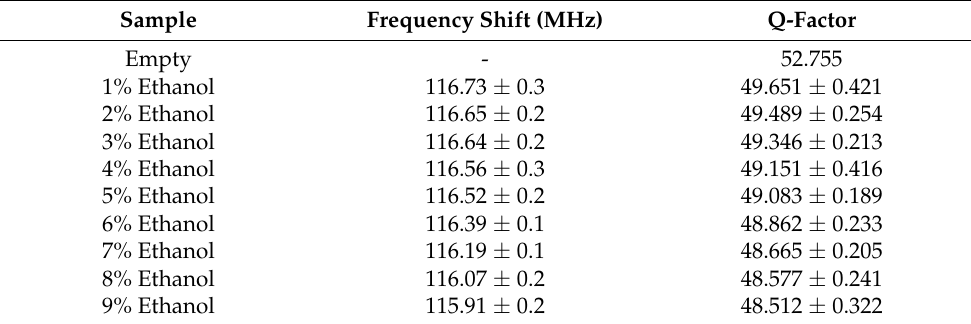
Figure 9. Measured transmission response of different concentrations of ethanol solution (from 1% to 9% with step of 1%). Table 4. The resonant frequency and Q-factor of different concentrations of ethanol-water solution (from 1% to 9% with step of